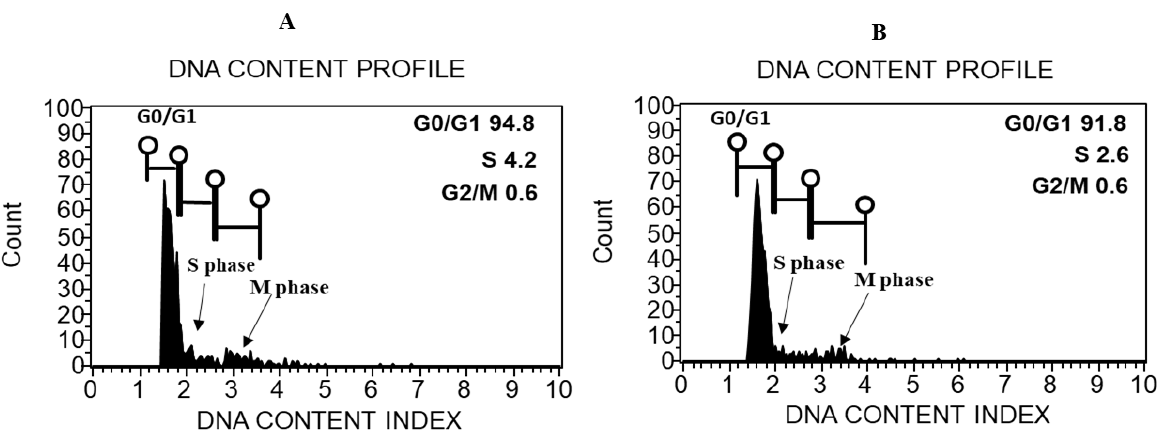
Figure 3. Flow cytometric histograms of the relative DNA content obtained from nuclei of Abrus precatorius : ( A ) nuclei extracted from the donor plant and ( B ) nuclei extracted from the callus. G0, G1, S, G2 and M indicate the interphase and the mitotic phase of the cell cycle.